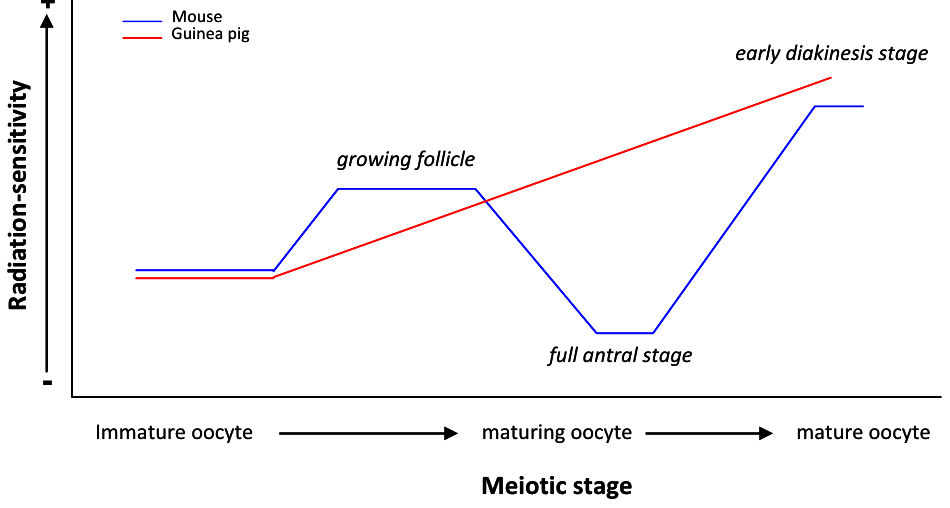
Figure 2. Comparison between genetic radiation-sensitivity observed in mouse and Guinea pig